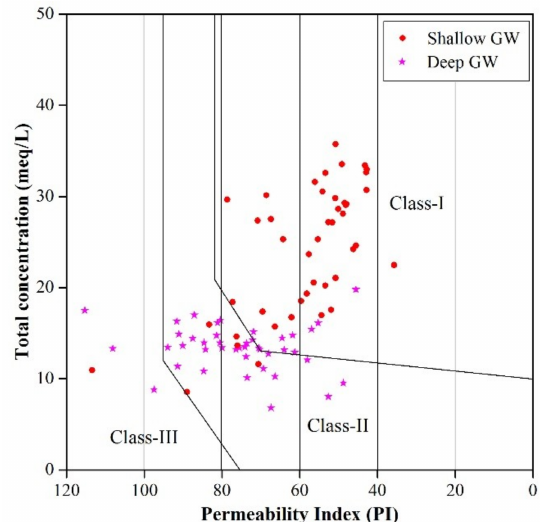
Figure 13. Classification of irrigation water based on permeability